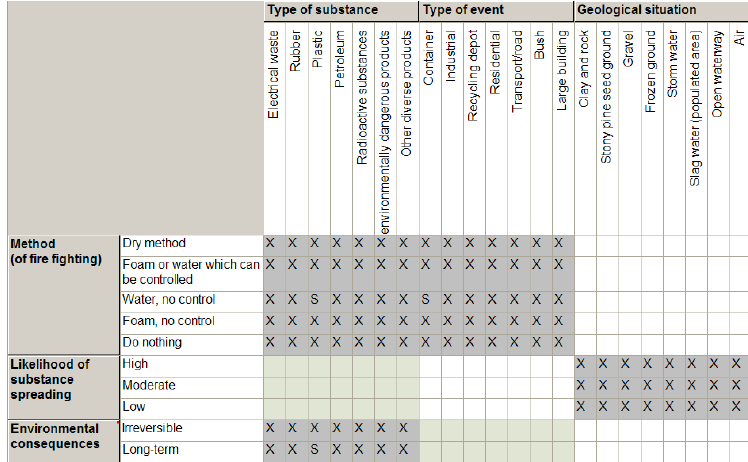
Figure 7: Cross-consistency matrix showing dependent variables (“X” markings).